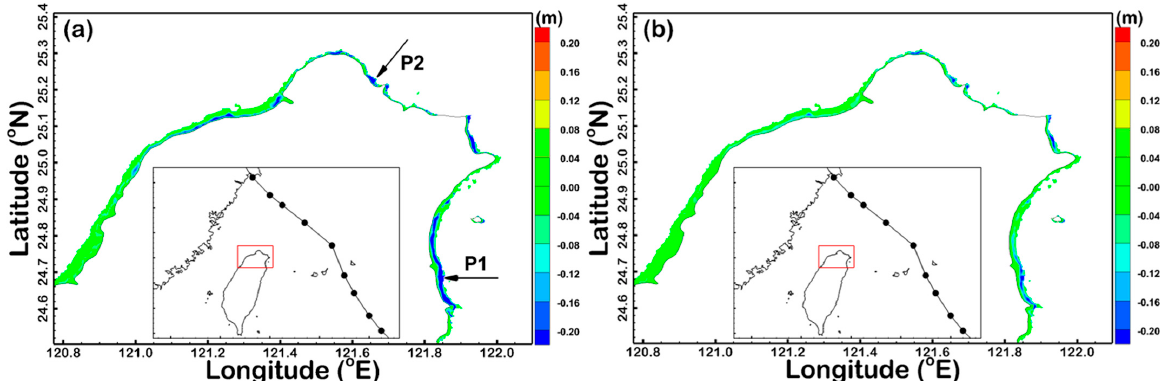
Figure 15. Spatial distribution of the difference in the maximum SWH between the scenarios of ( a ) S_NO1 and S_NO4 and ( b ) S_NO1 and S_NO5 during the passage of Super Typhoon Lekima in 2019. The areas with water depths greater than − 20 m are shown.